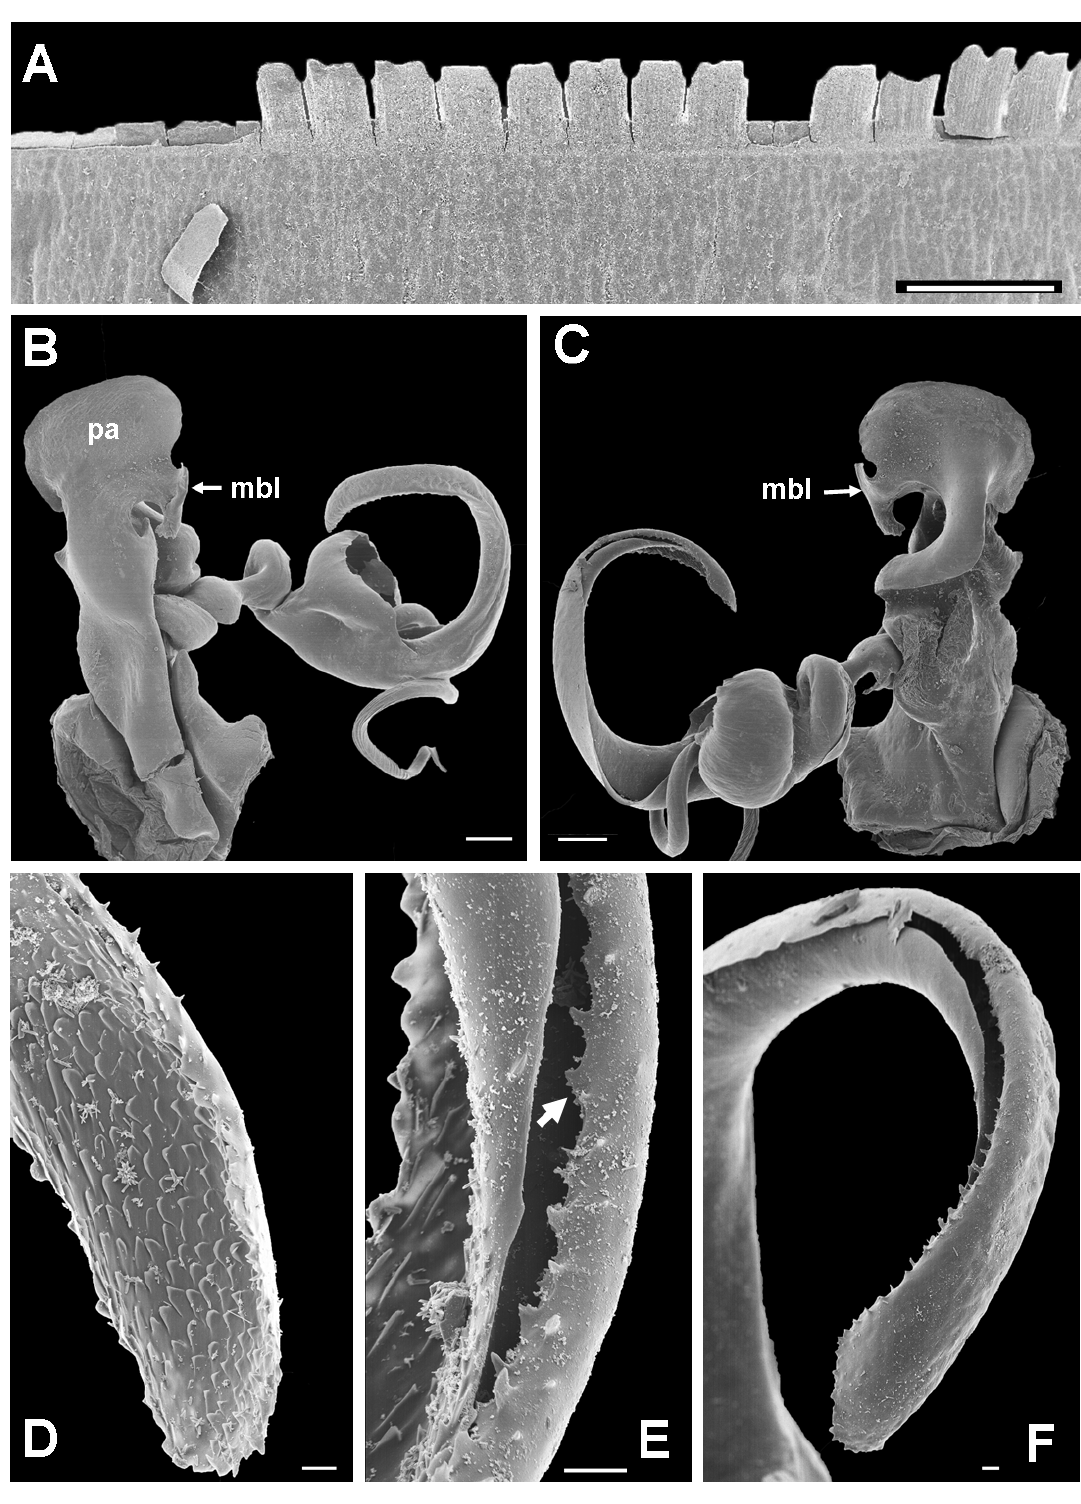
Fig. 7. Aquattuor fasciatus (Attems, 1896) comb. nov., specimen from Zanzibar, Kirimkazi. A . Limbus. B – C . Left gonopod. B. Anterior view. C. Posterior view. D – F . Left telomere. D. Tip, basal-anterior view. E. Subdistal part, posterior view (bold arrow points to a microserrate lobe on the margin). F. Tip, apical-posterior view. Abbreviations: mbl = mesobasal lobe of coxal palette; pa = apical palette of coxa. Scale bars: A–C = 0.1 mm; D–F = 0.01